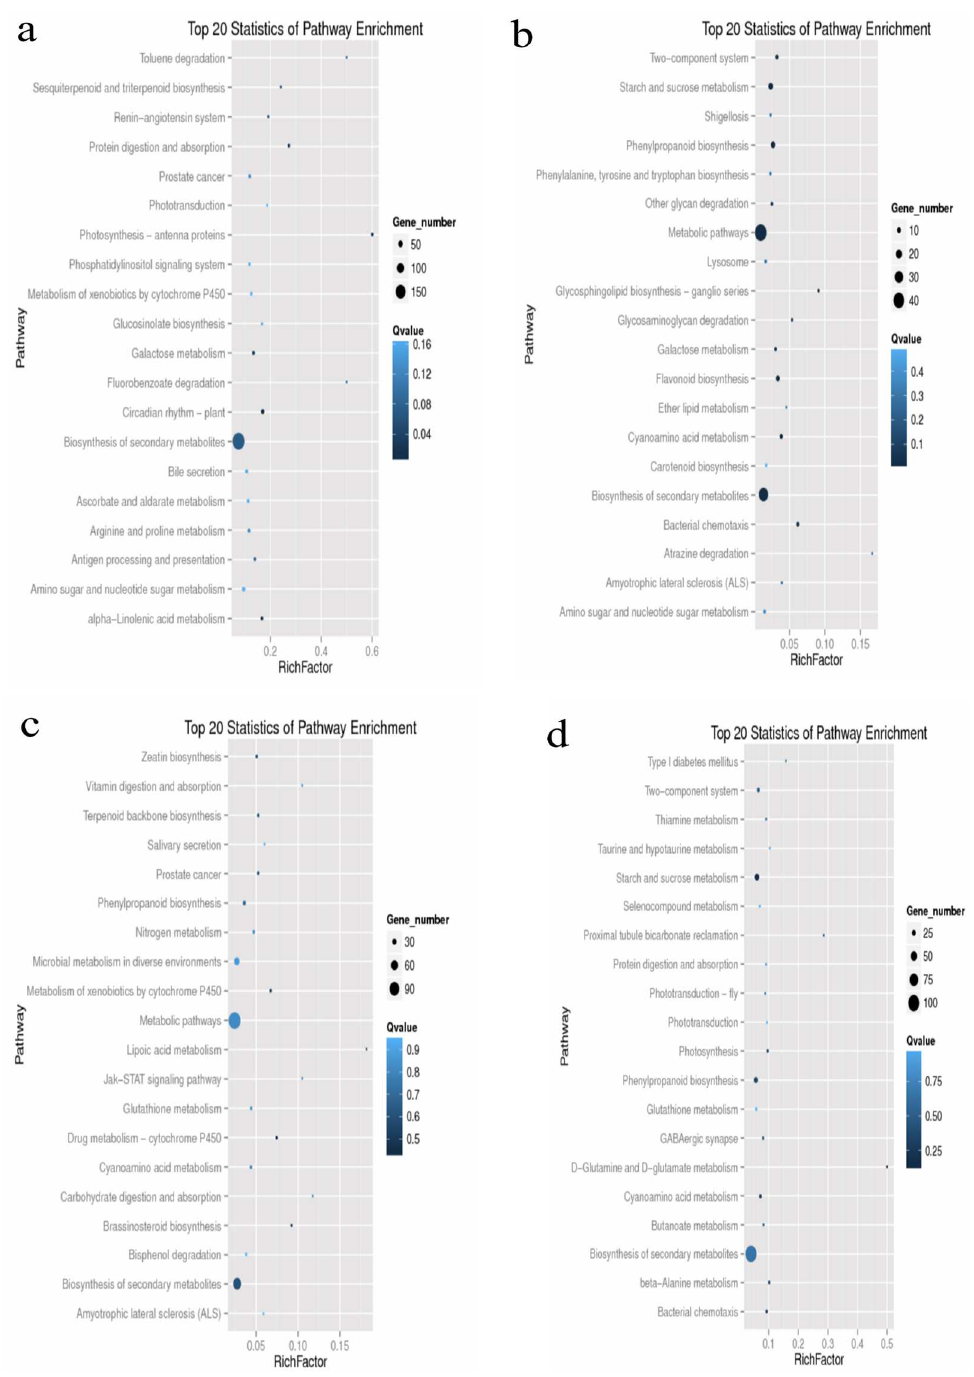
Fig 5. Scatter plot of KEGG pathway enrichment statistics of the comparison schemes. Top 20 statistics of pathwayenrichmentfor ComparisonA (a), ComparisonB (b), ComparisonC (c), ComparisonD (d), respectively.